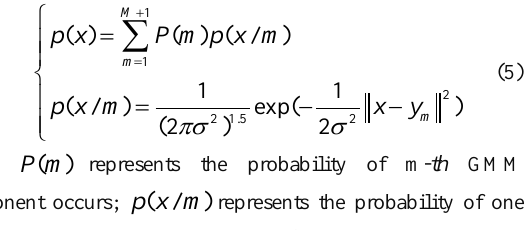
Figure 2. Illustration of three local feature variables. (a) Deviation angle between normal. (b) Local distance.